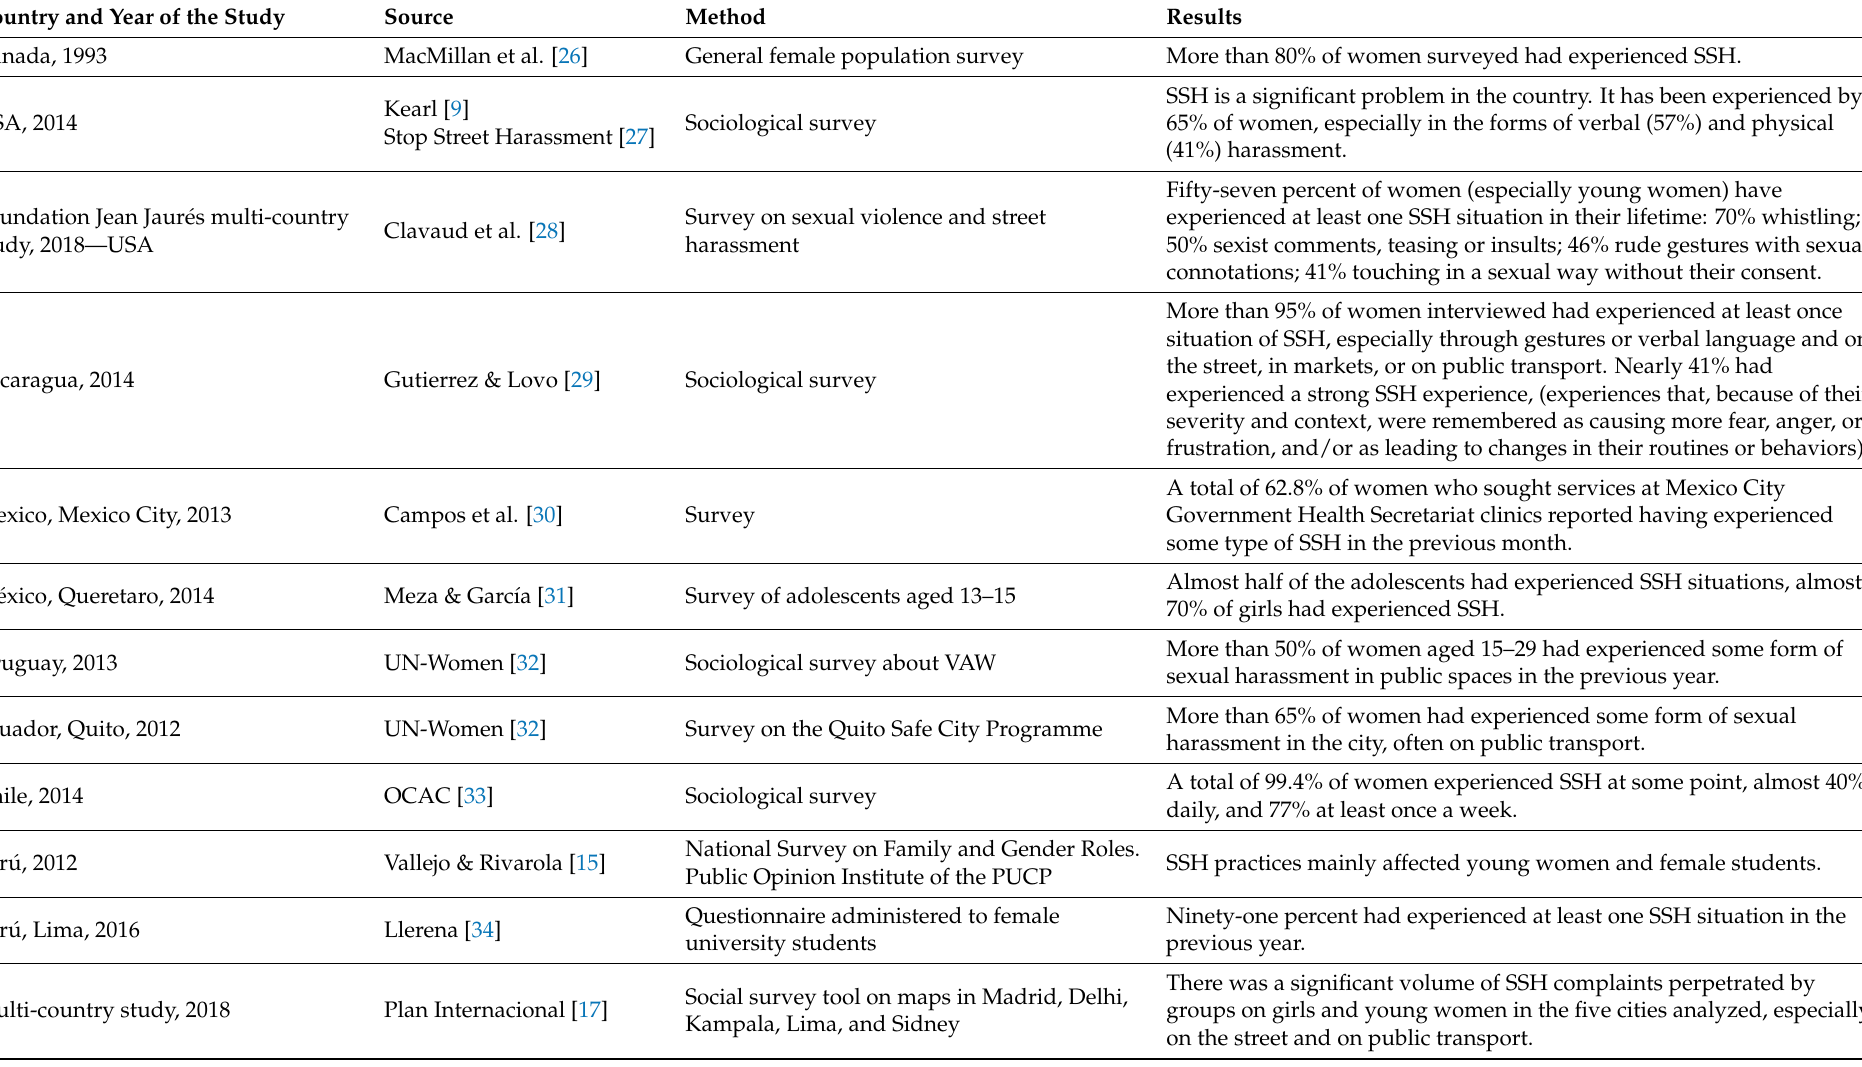
Table 1. SSH (street sexual harassment)